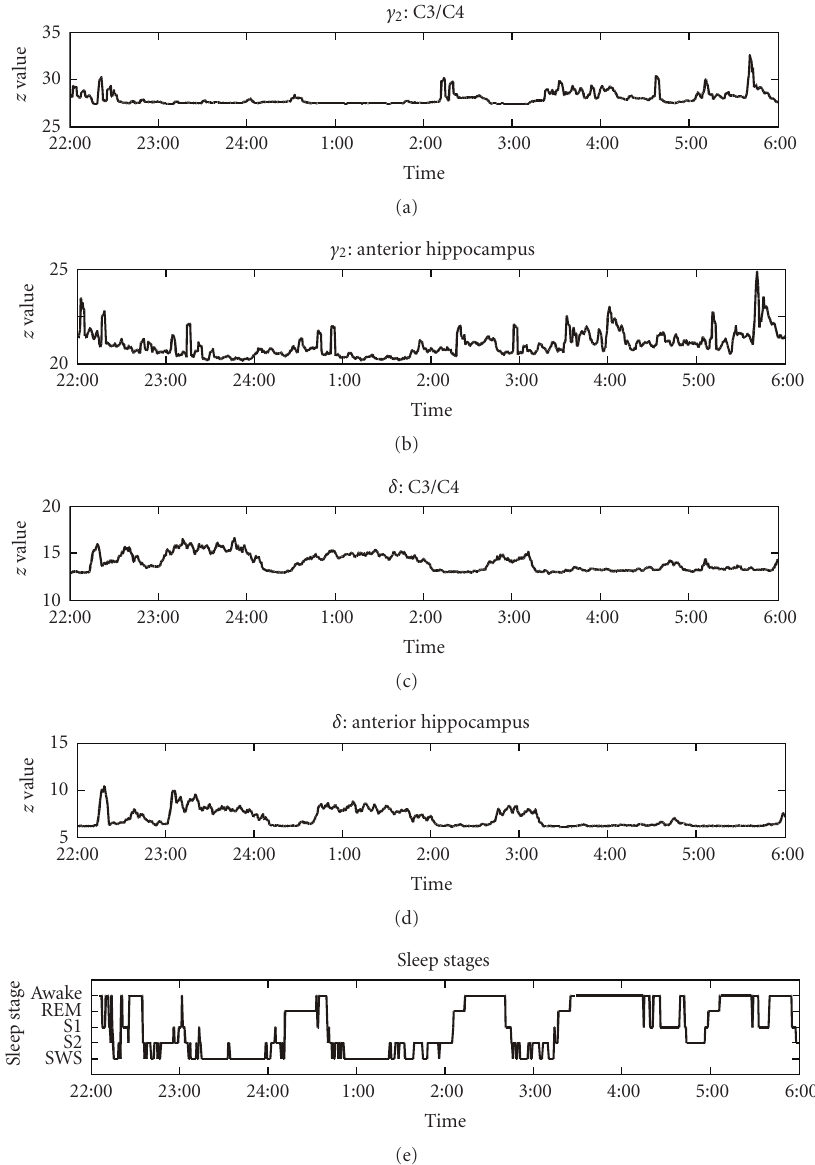
Figure 1: Time course of γ 2 and δ band activity in scalp EEG and in the anterior hippocampus and sleep stages during one night in one exemplary subject. S1: sleep stage 1, S2: sleep stage 2, SWS: slow wave